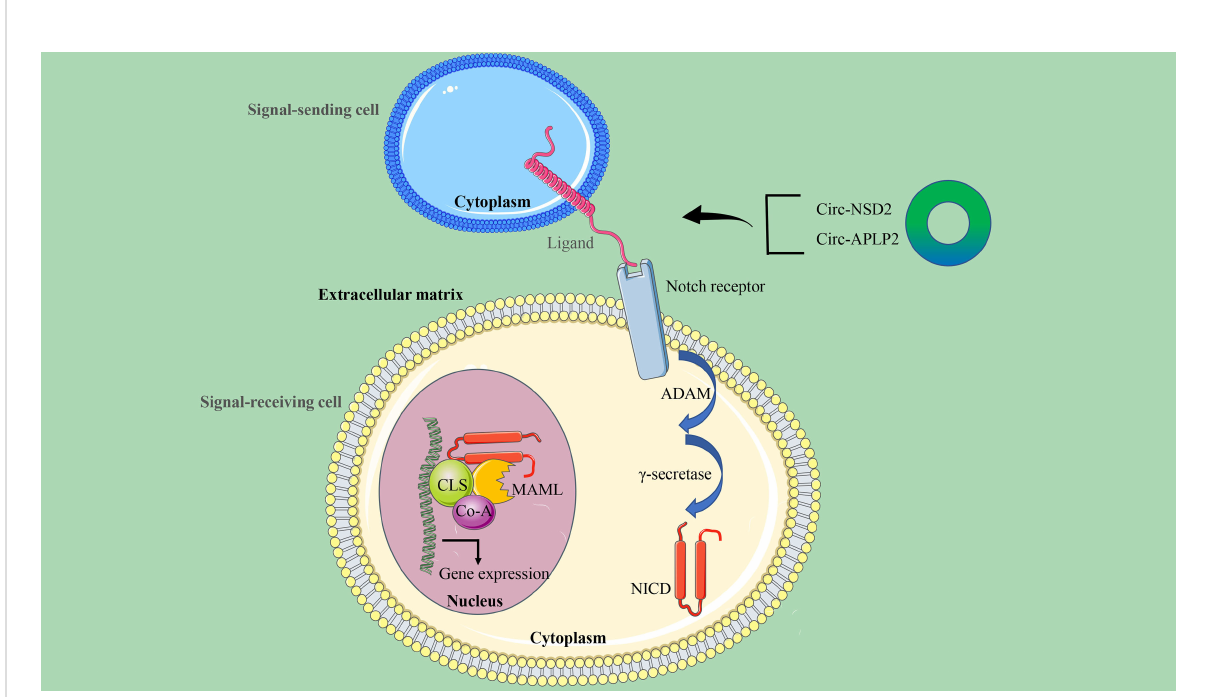
FIGURE 6 The circRNA/Notch signaling axis in CRC. This signaling is initiated by ligand-receptor binding between the signal-sending cell and the signal- receiving cell. The receptor-ligand interaction triggers a continuous cleavage mediated by ADAM metalloproteinase and g -secretase, followed by the release of the intracellular domain NICD by Notch. When NICD is transferred to the nucleus, it recruits MAML and Co-A to CSL to initiate the expression of target